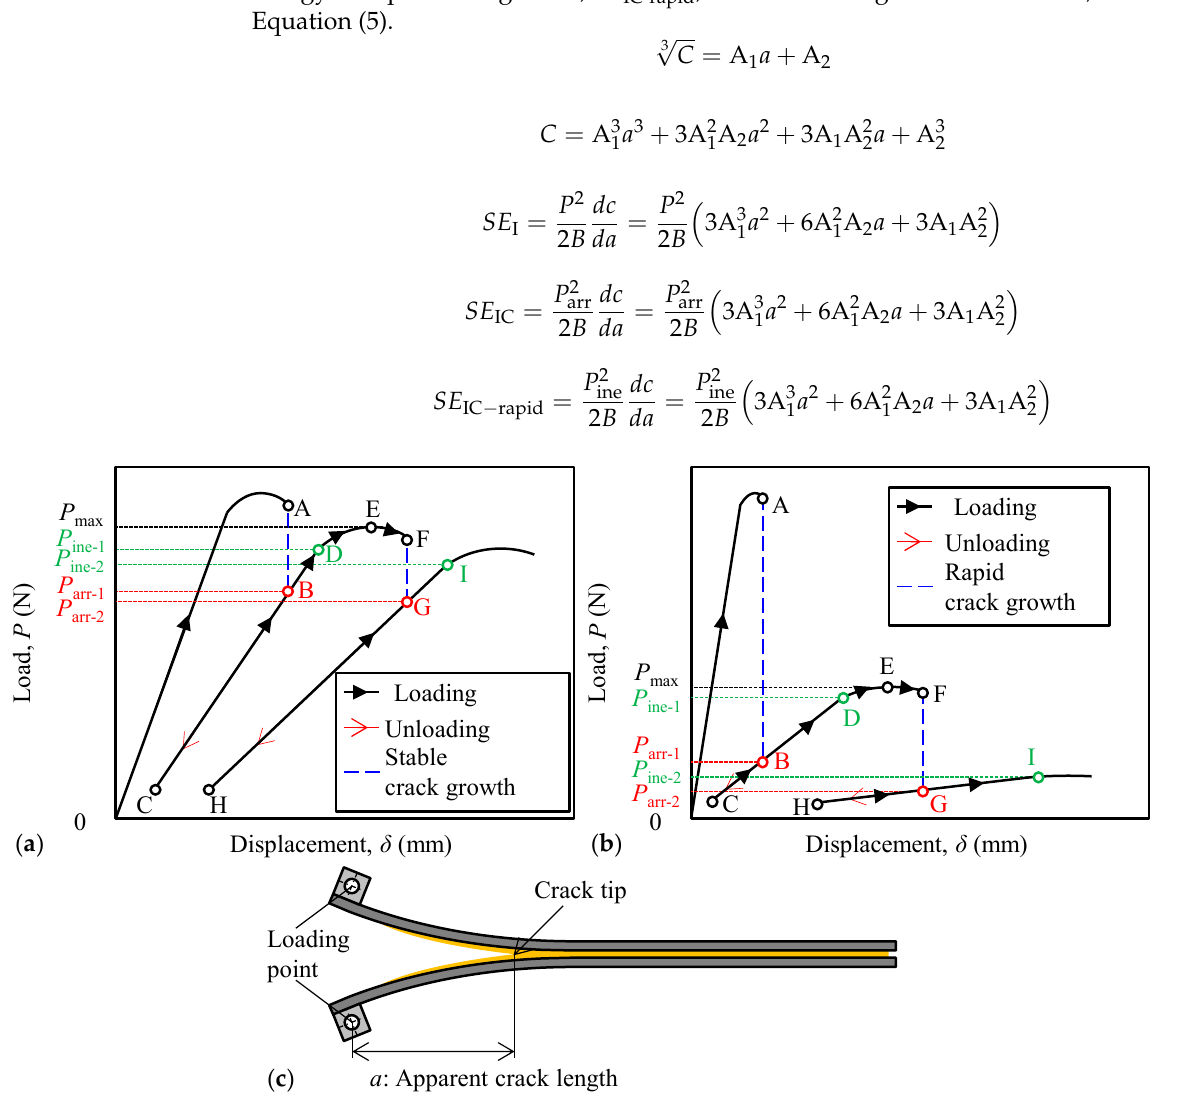
Figure 2. Illustration of loading–unloading test method in case of ( a ) stable crack propagation and ( b ) rapid crack propagation; ( c ) Schematic illustration on the de fi nition of apparent crack length.